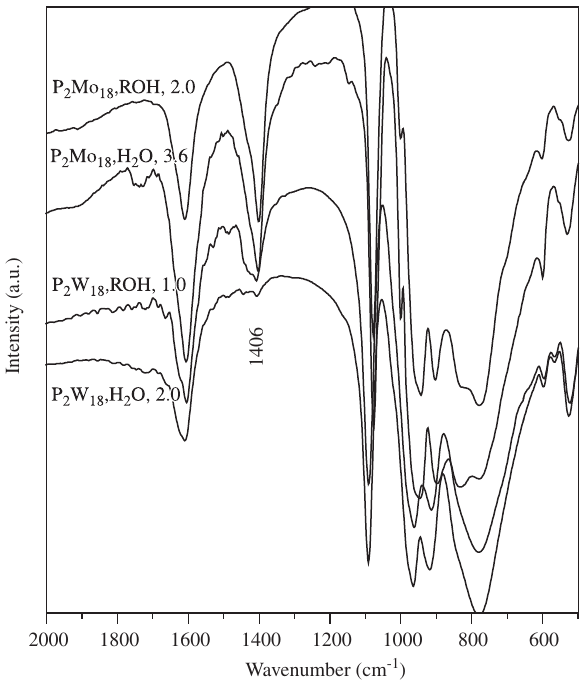
Figure 5. Infrared spectra of the materials obtained through the ion exchange of the (NH containing (1:3) salt:resin weight ratio. The spectra are labeled with the name of the starting salt (P ethanol (ROH) media] and the flow rate of the effluent